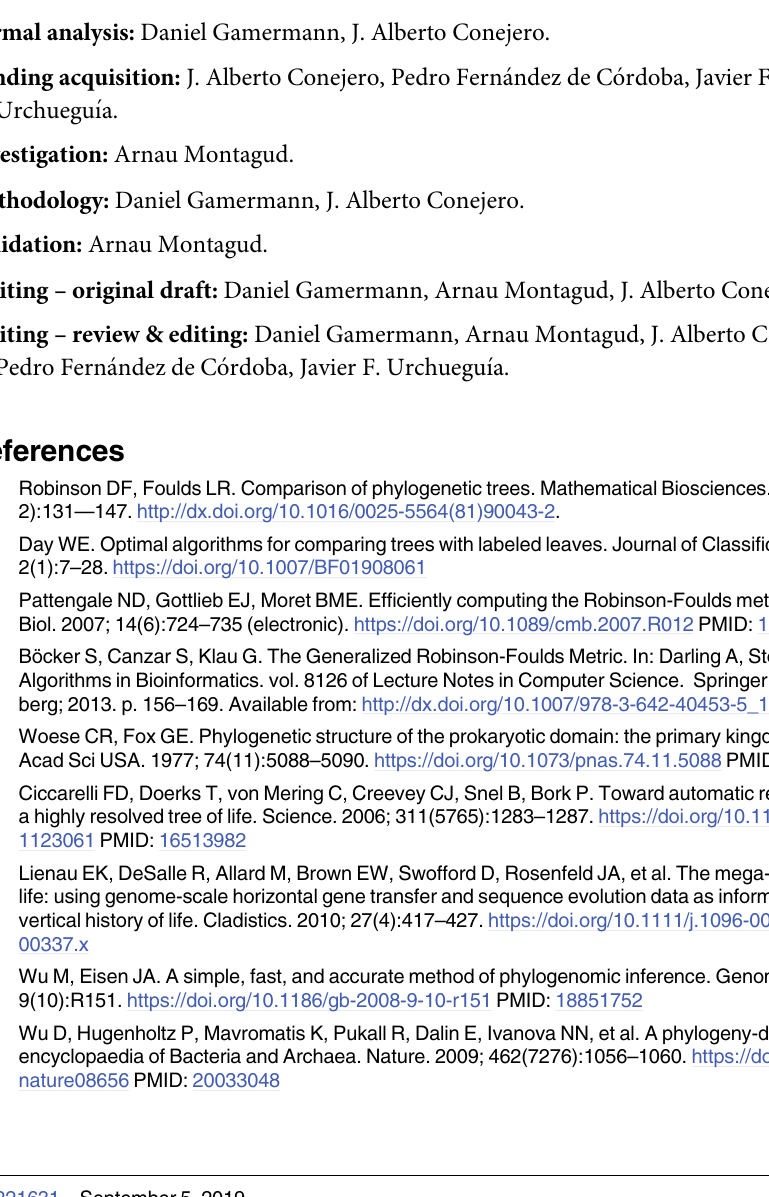
(referred to by their KEGG code) in each set in each ensemble used in this work. S3 File. Dendrograms of each ensemble. The file trees.txt contains all dendrograms generated for each set in each ensemble in newick